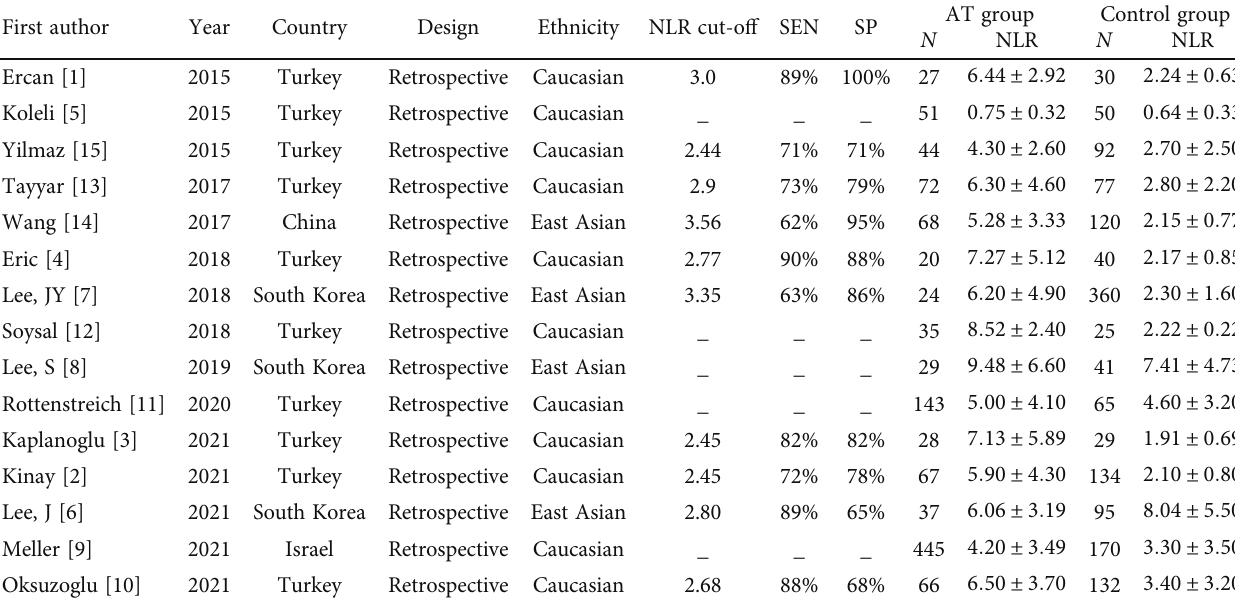
Table 1: General characteristics of included